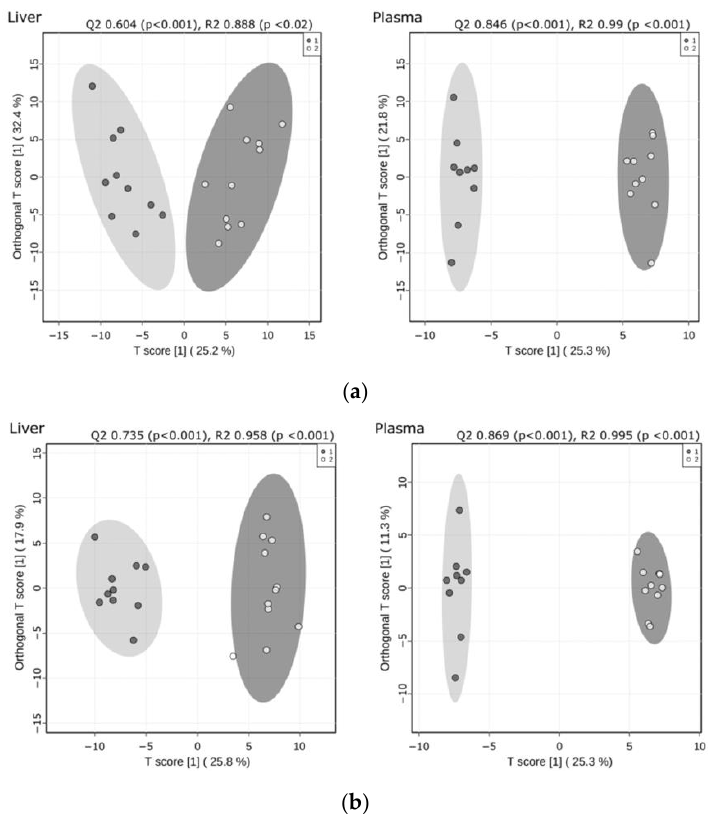
Figure 1. OPLS-DA shows the separation of WT (black circles) and CypD -/- (open circles) lip- idomes. The analysis was performed using ( a ) absolute (lipid nmol/liver mg or lipid nmol/plasma mL) and ( b ) relative (mol% of polar lipids) lipid concentrations. Permutation tests ( n = 1000) revealed a good predictability (Q2) and high goodness of fit (R2) as indicated.